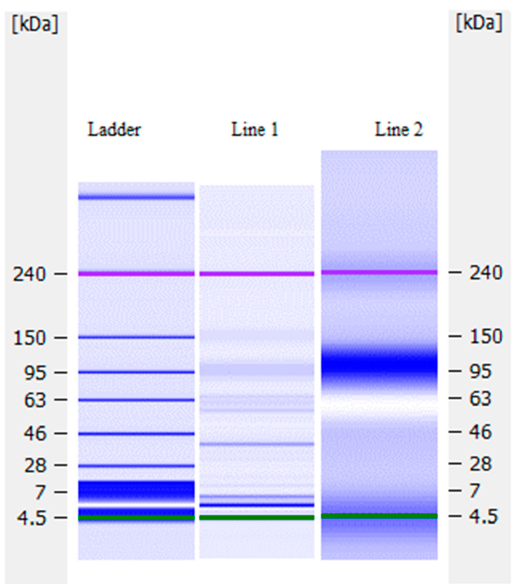
Figure 9. Tear protein profile of the Experiment 2 samples: Line 1 = ‘Native’ non-plasma treated laccase; Line 2 = Plasma deposited sample at 4 kV, 30 s.